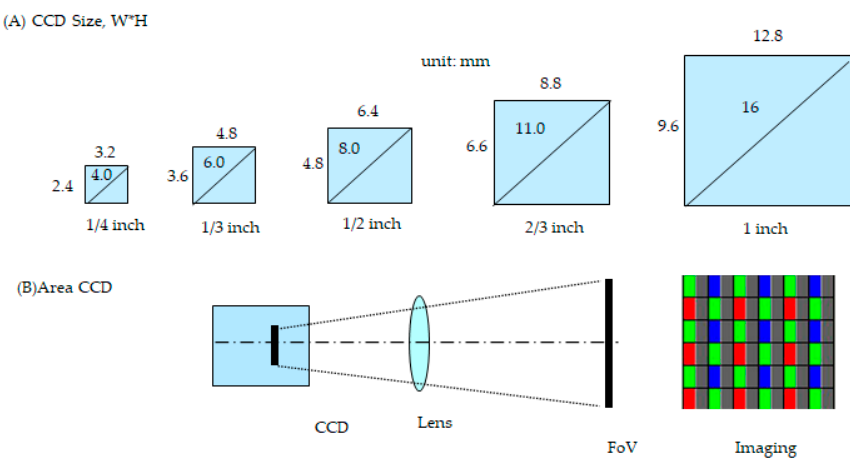
Figure 2. Illustration of various sizes of charge-coupled devices (CCDs) from small to large at the field of view: ( A ) various CCDs; and ( B ) demonstrates an optical path with the field of view.